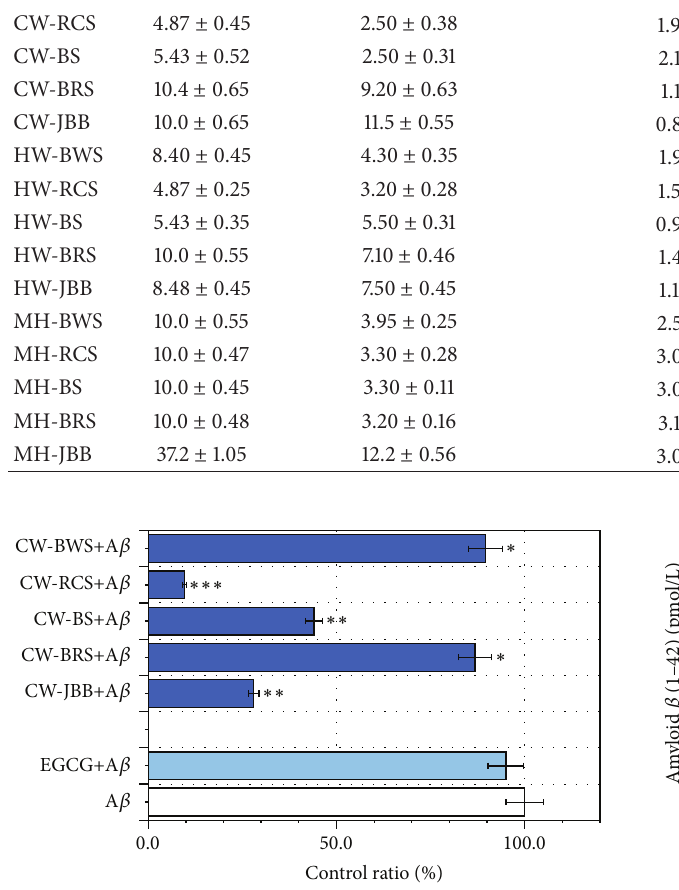
Figure 3: The correlation between levels of A 𝛽 (1–42) and total phenolic contents of aqueous extracts from the sprouts of five